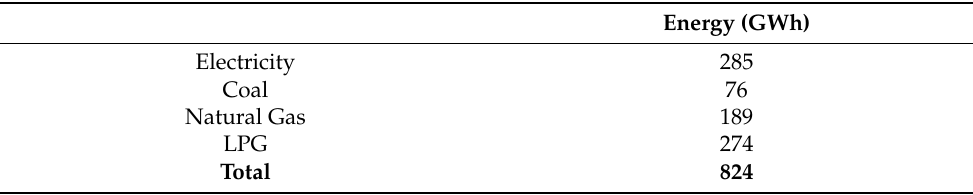
Table 2. Energy consumption from commercial cooking activities in the GAA, as produced by the present study.